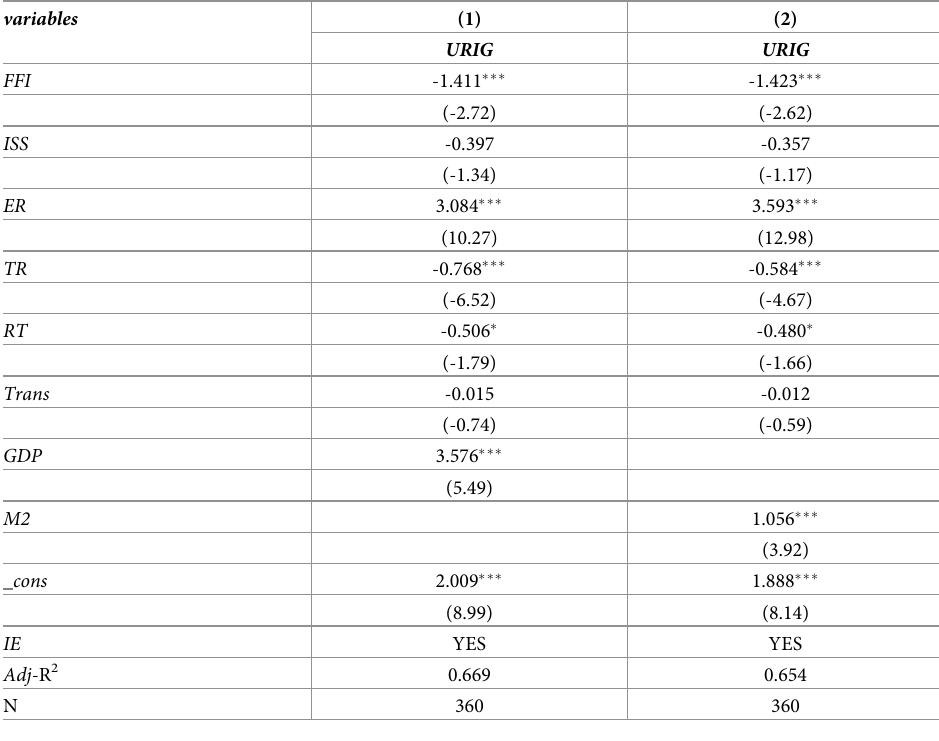
Table 7. Robustness test: Controlling macroeconomic